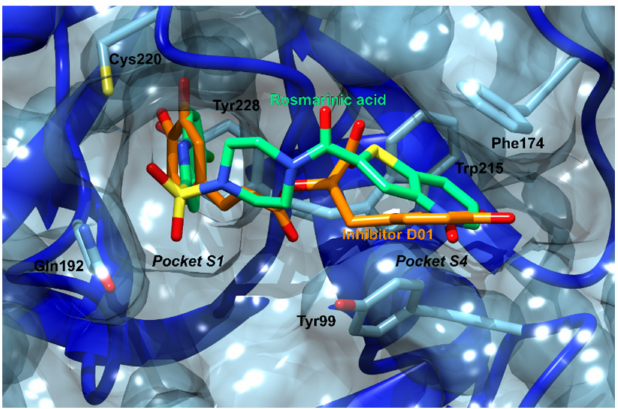
Figure 10. Factor Xa binding site. Factor Xa is shown in blue ribbons and surface, its important amino acid residues in blue sticks. Rosmarinic acid (green carbons) is docked in the same binding site as the one occupied by a known inhibitor (orange sticks) with a PDB ID: D01. The caffeic acid part of rosmarinic acid docks to the S1 pocket, and the 3,4-dihydroxyphenyllactic acid moiety to the S4